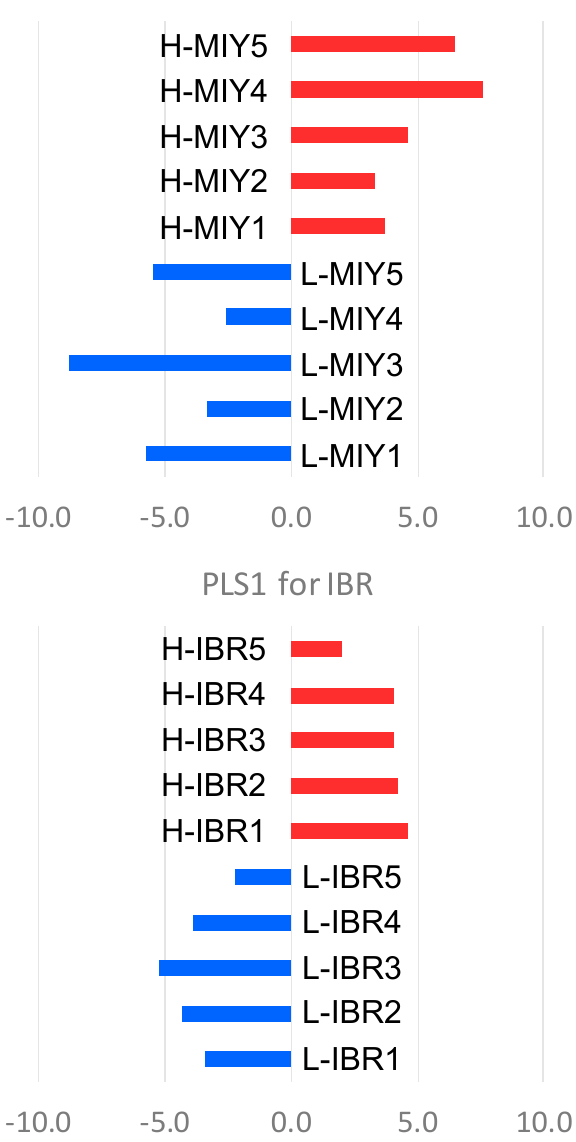
Figure 1. Partial least squares (PLS) analysis by the metabolites detected from pig plasma samples showing the difference in the intramuscular fat contents at the two stations. Blue and red bars indicate low and high IMF pigs, respectively. Top and bottom panes show the results of PLS in MIY and IBR stations, respectively.